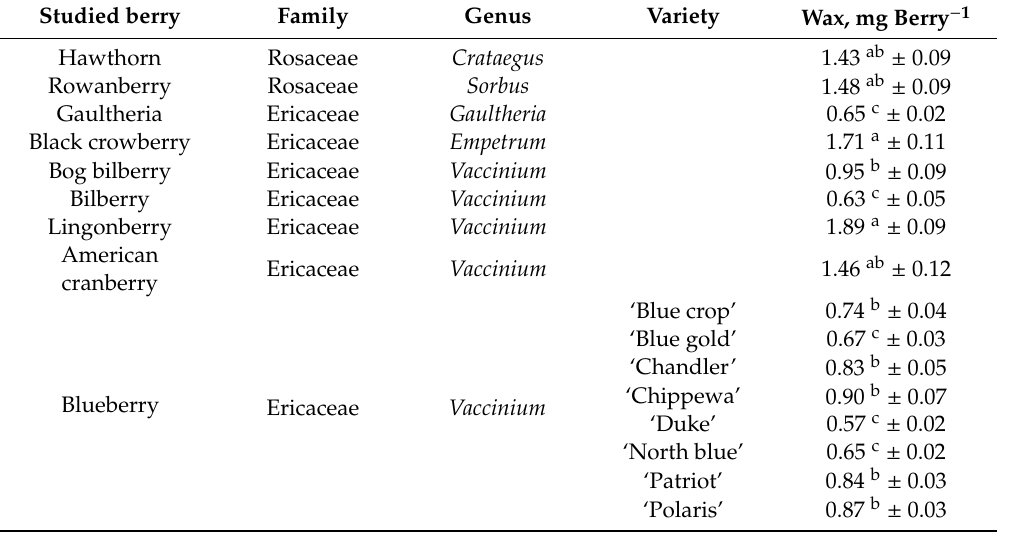
Table 1. Studied berries, their taxonomic relation based on family and genus, and the amount of wax in mg per fresh berry. ± represents the standard deviation of the wax amount ( n = 6). Means with di ff erent letters are significantly di ff erent (Tukey’s HSD, p < 0.05). Studied berry Family